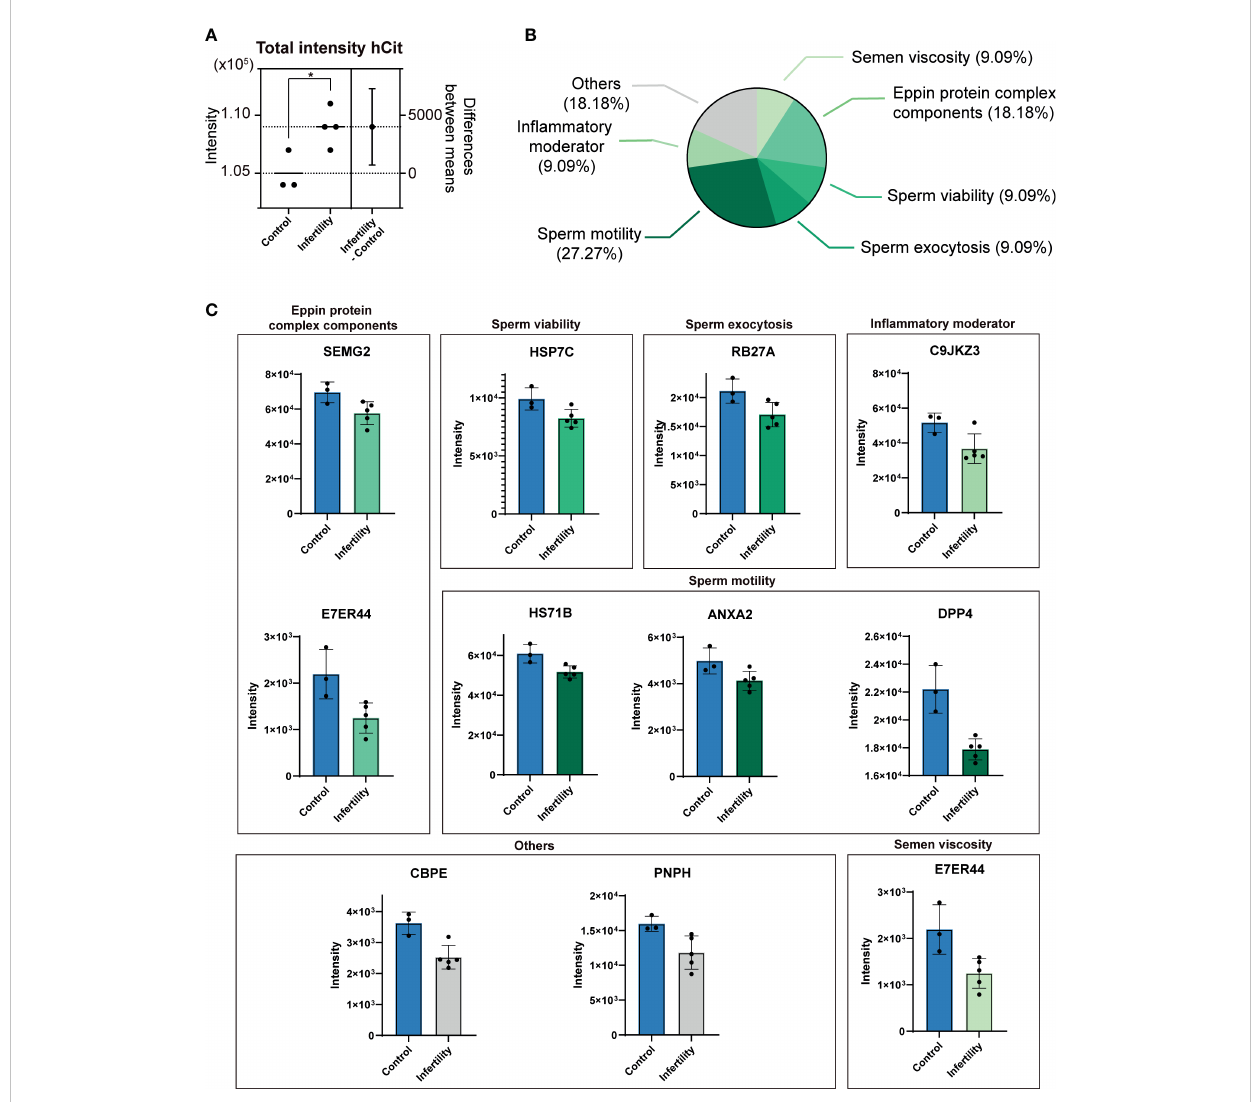
FIGURE 2 Differential presence of ureido protein modi fi cations (uPMs) in sEV proteomes of non-normozoospermic (non-NZ) men compared to healthy controls (NZ). (A) The total cumulative intensity of homocitrullinated (hCit) proteins in sEV proteomes detected in non-NZ and NZ subjects. The intensity was calculated as the sum of spectral counts of all hCit-modi fi ed peptides identi fi ed. The difference between non-NZ and NZ (nonNZ-NZ) is displayed using the right y -axis. (B) Functional categorization of Cit proteins in sEV proteomes signi fi cantly modulated in non-NZ subjects compared to NZ. (C) Relative quanti fi cation of signi fi cantly modulated citrullinated (Cit) proteins in sEV proteomes from non-NZ and NZ. *p ≤ 0.05, signi fi cant differences. Signi fi cant differences between groups were assessed by the Student ’ s